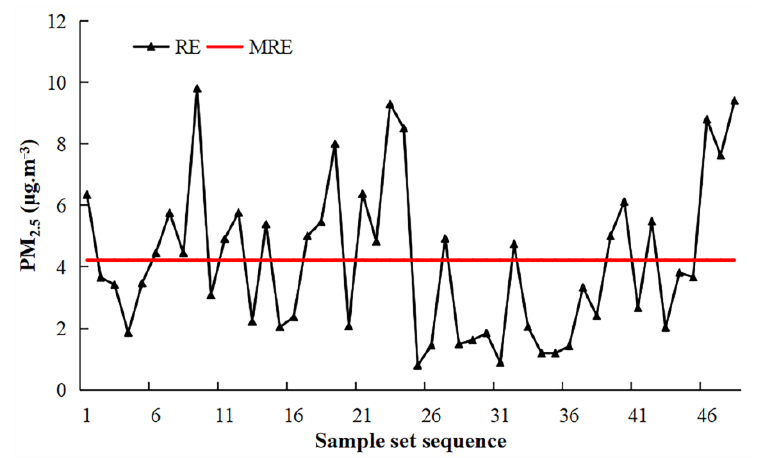
Figure 7. Error distribution of the estimated PM 2.5 concentration, given the sample set sequence. RE refers to the real error of each station in the four seasons. MRE refers to the mean real error of 47 stations in the four seasons.